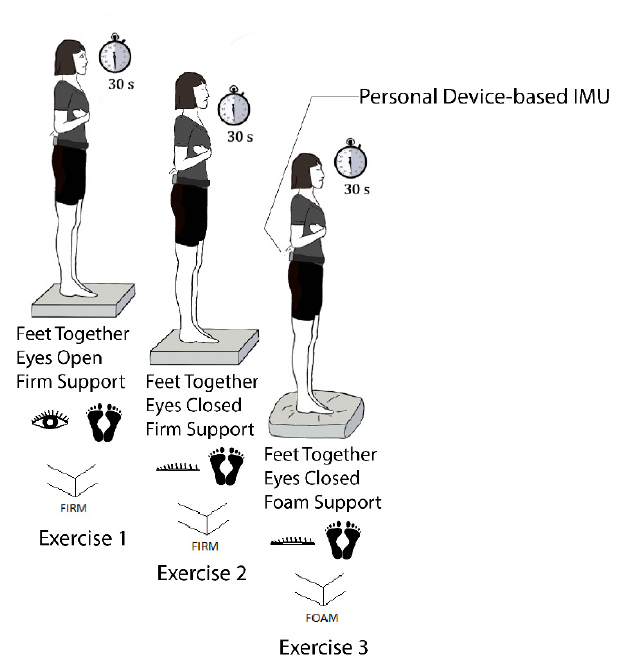
Figure 1. Left panel: Balance exercises are shown in the order in which they were